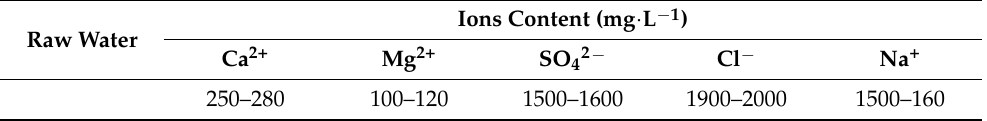
Table 2. The main ion content of the wastewater.